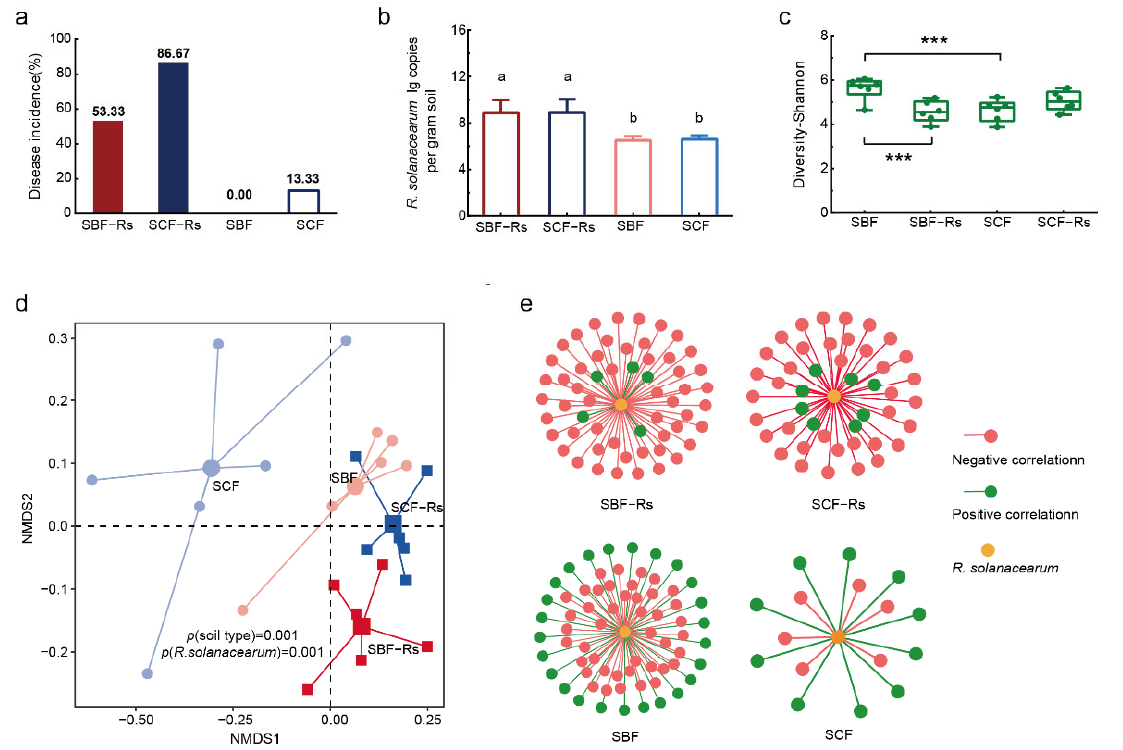
Figure 2. Bacterial wilt disease incidence, bacterial community composition and responsive bacterial taxa in Experiment I. ( a ) Bacterial wilt disease incidence (%); ( b ) The abundance of R. solanacearum in the rhizosphere obtained via quantitative PCR; ( c ) Alpha diversity analysis of rhizosphere bacterial communities (Shannon index); ( d ) Non-metric multidimensional scaling (NMDS) and PERMANOVA analysis of rhizosphere bacterial communities; ( e ) Analysis of responsive microbial taxa. Network showing the number of significant responsive bacterial genera. SBF: rhizosphere derived from the BF soil without R. solanacearum inoculation; SCF: rhizosphere derived from the CF soil without R. solanacearum inoculation; SBF-Rs: rhizosphere derived from the BF soil and inoculated with R. solanacearum at the same time that plants were transferred to the split-root system; SCF-Rs: rhizosphere derived from the CF soil and inoculated with R. solanacearum at the same time that plants were transferred to the split-root system. Different letters above the bars indicate significant differences at p < 0.05 based on one-way analysis of variance (ANOVA). The asterisks indicate significant differences between treatments determined by two-sample t -tests (*** p <